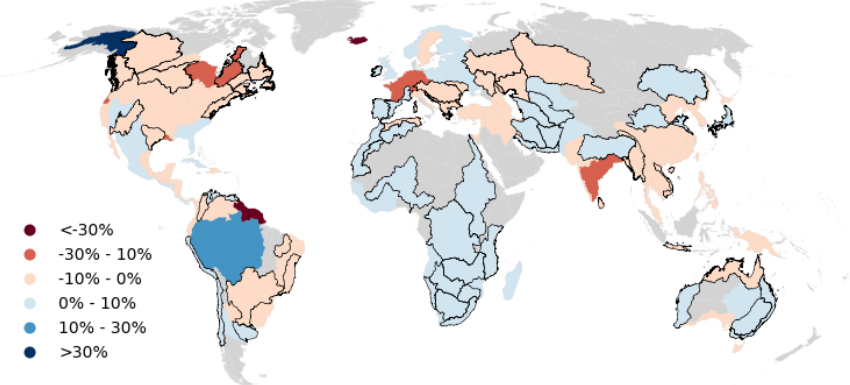
Figure 10. The ratio of the linear trends in net evaporation and storage for each basin.